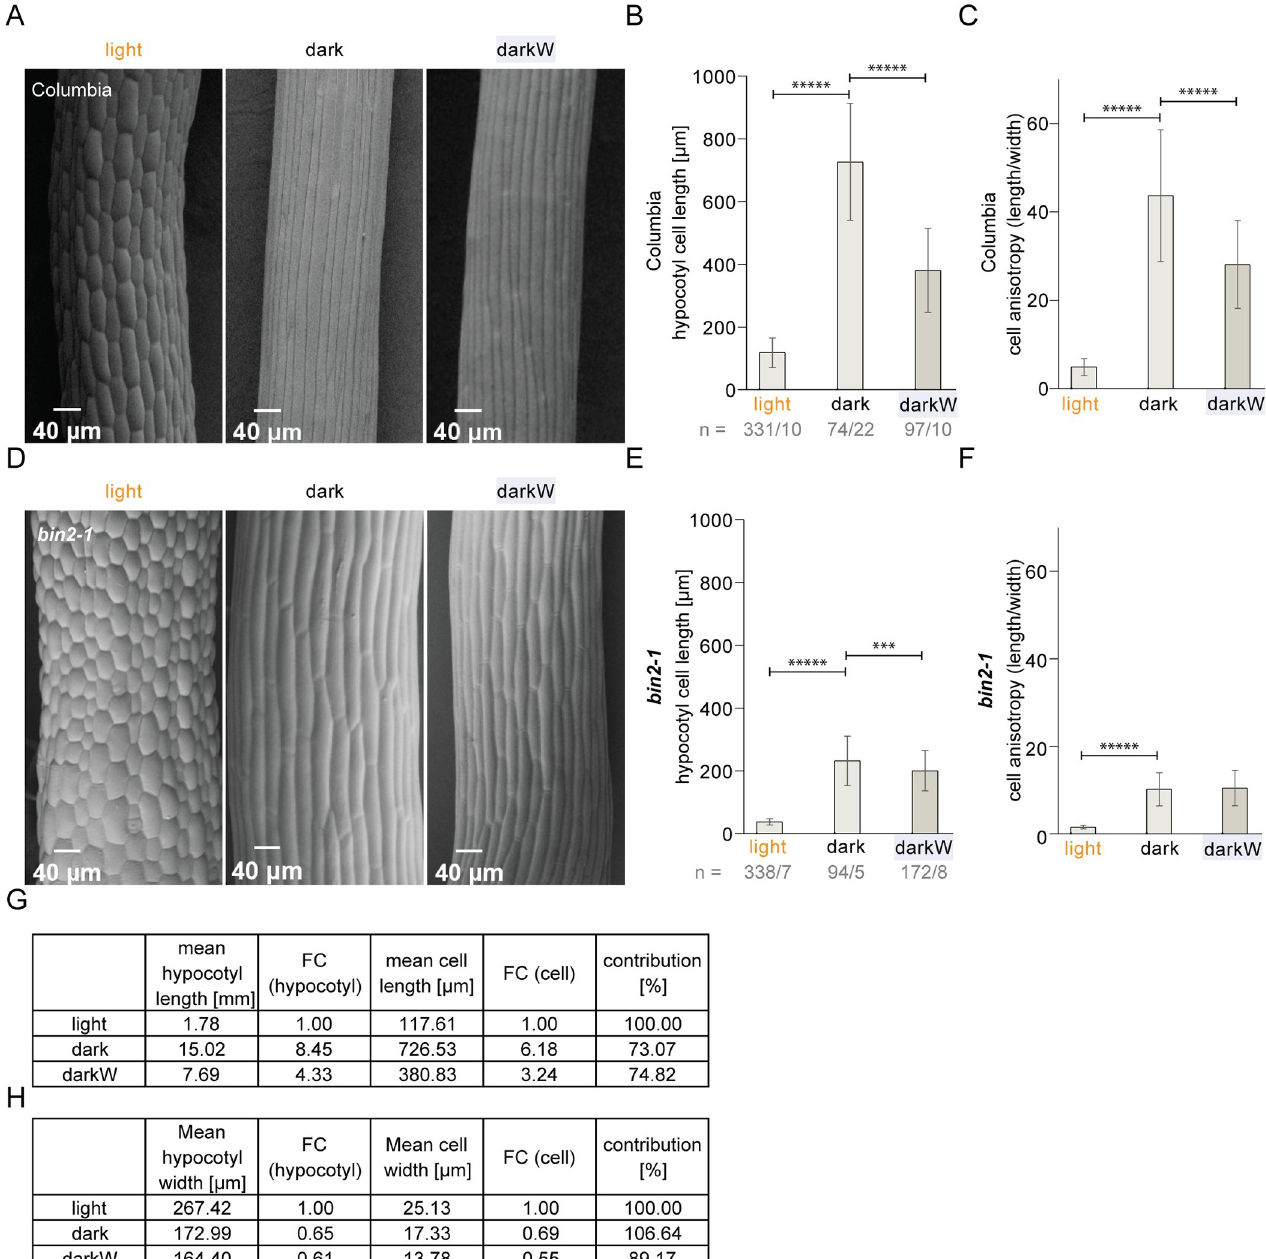
Fig 5. Hypocotyl properties under single versus multiple stress conditions in wildtype and bin2-1 mutants. Seed were germinated on 1/2MS medium and incubated for ten days under light, dark or darkW conditions. (A-C) Col-0 wild type; (D-F) bin2-1 semi-dominant allele. Scanning electron micrographs (A, D) were used to assess cellular parameters. (B, E) hypocotyl cell length. (C, F) hypocotyl cell anisotropy measured in 2D as length/width. Notice the highly significant decrease in anisotropy in the wild type (C) but the lack of response in bin2-1 (F) for darkW as compared to dark. (G, H) A comparison of organ versus cell parameters for the Col-0 wild type under the different environmental conditions, with a computation of fold-changes (FC) with respect to the light condition. Mean cell width significantly (P < 0.00001; not shown) decreased between light and dark and again between dark and darkW (H). Note that, as depicted in the last columns labelled “contributions”, the cellular parameters can account for 73–74% of organ length and 89–106% of organ width. The sample size (n) is given as the number of cells/ number of seedlings that were analysed. P-values were computed with a two-tailed student’s T-test and are represented as follows: ��� : 0.001–0.0001; ����� : < 0.00001. See related Fig 7